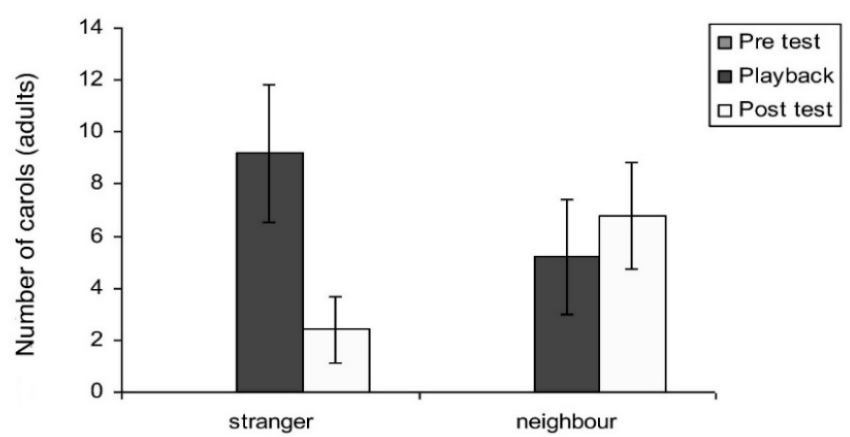
Figure 13. Vocal response by adult magpies ( N = 10) to carol playback over a 15-min test period. As in warble–carols, the post-test response was significant when comparing responses to carolling of strangers and neighbours. The mean of three trials played inside the territory of focal magpies (for the post-test period: F 2,10 = 10.43; p = 0.001). Graph indicates mean number and standard error of all adult warbles in response to carolling playbacks. Note again the importance of the post-playback period, showing that the vocal response continued after hearing a neighbour carol inside their territory (no significant difference to test period, while the incidence of carolling to a stranger drops off quickly, i.e., in the first minute of the post-test period. Well before the post-test period ended any carolling to a stranger had ceased while, in the 5 min of the post test, carolling continued throughout in response to a neighbour.